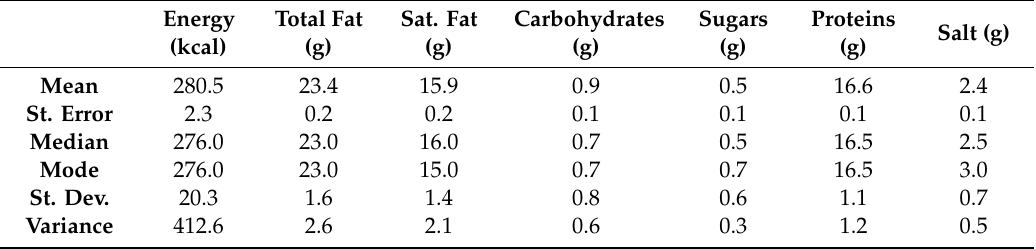
Table 2. Descriptive statistics of nutritional characteristics (per 100 g) of prepacked protected designation of origin (PDO) feta cheese products in the Greek market.